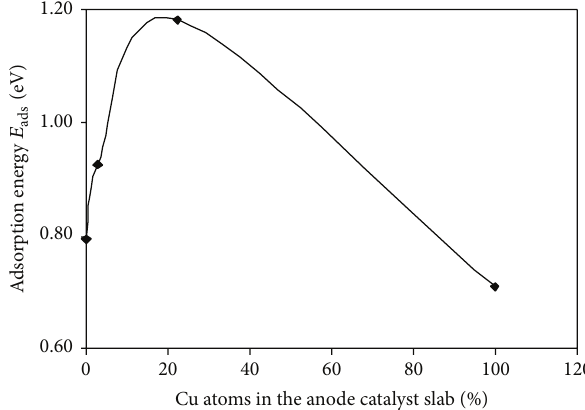
Figure 5: DFT calculated adsorption energies for water on the surface of NiFe alloy slab with various compositions (0% Fe, 2.8% Fe, 22.2% Fe, and 100% Fe).